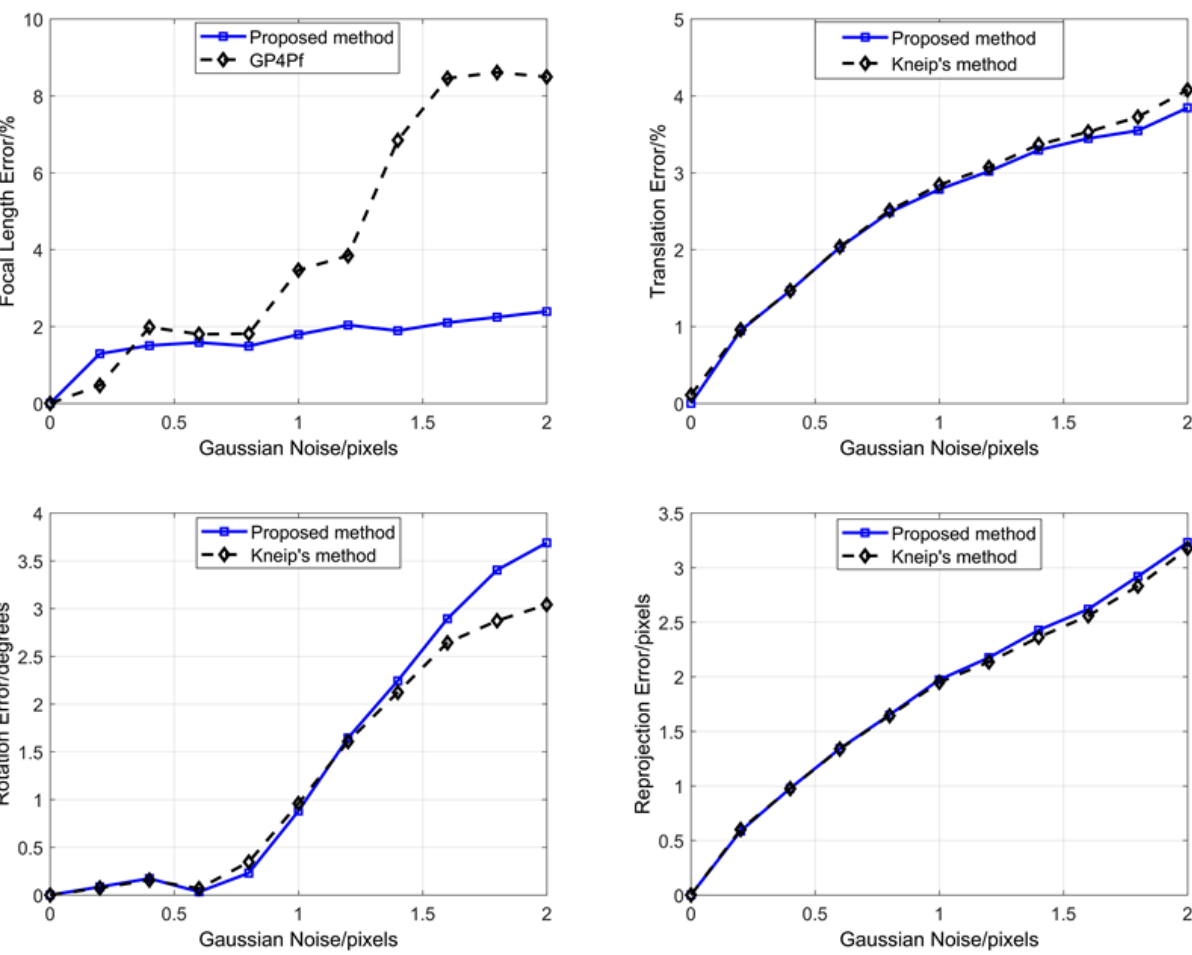
Figure 7. Experiment results of noise sensitivity.